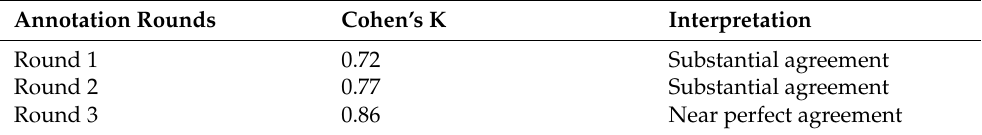
Table 2. Cohen’s K during the initial annotation process for guideline